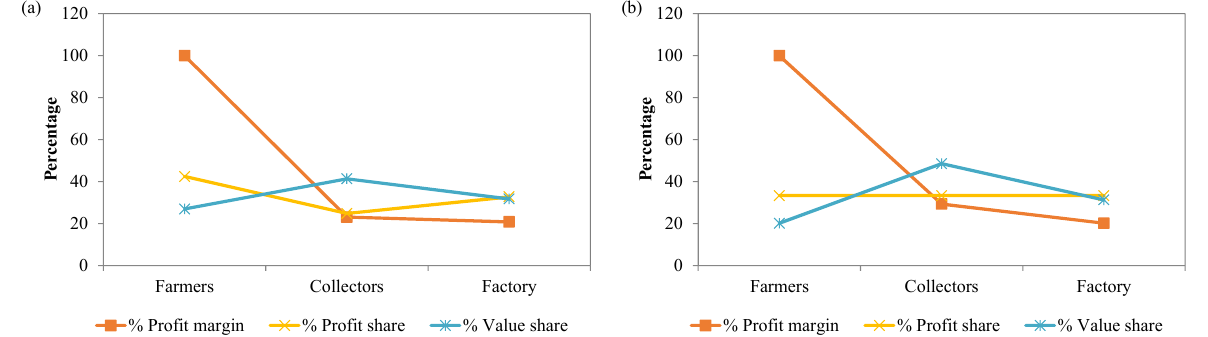
Figure 8. Profit margin, profit share, and value share of different stakeholders in waste value chain Figure 8. Pro fi t margin, pro fi t share, and value share of di ff erent stakeholders in waste value chain from ( a ) scenario C2 and ( b ) scenario E. from ( a ) scenario C2 and ( b ) scenario E.